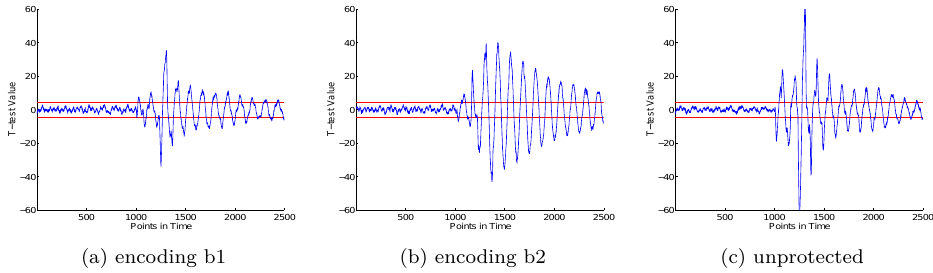
Figure 12: TVLA on SKINNY . The red lines indicate the upper and lower limits of the TVLA threshold ( ±